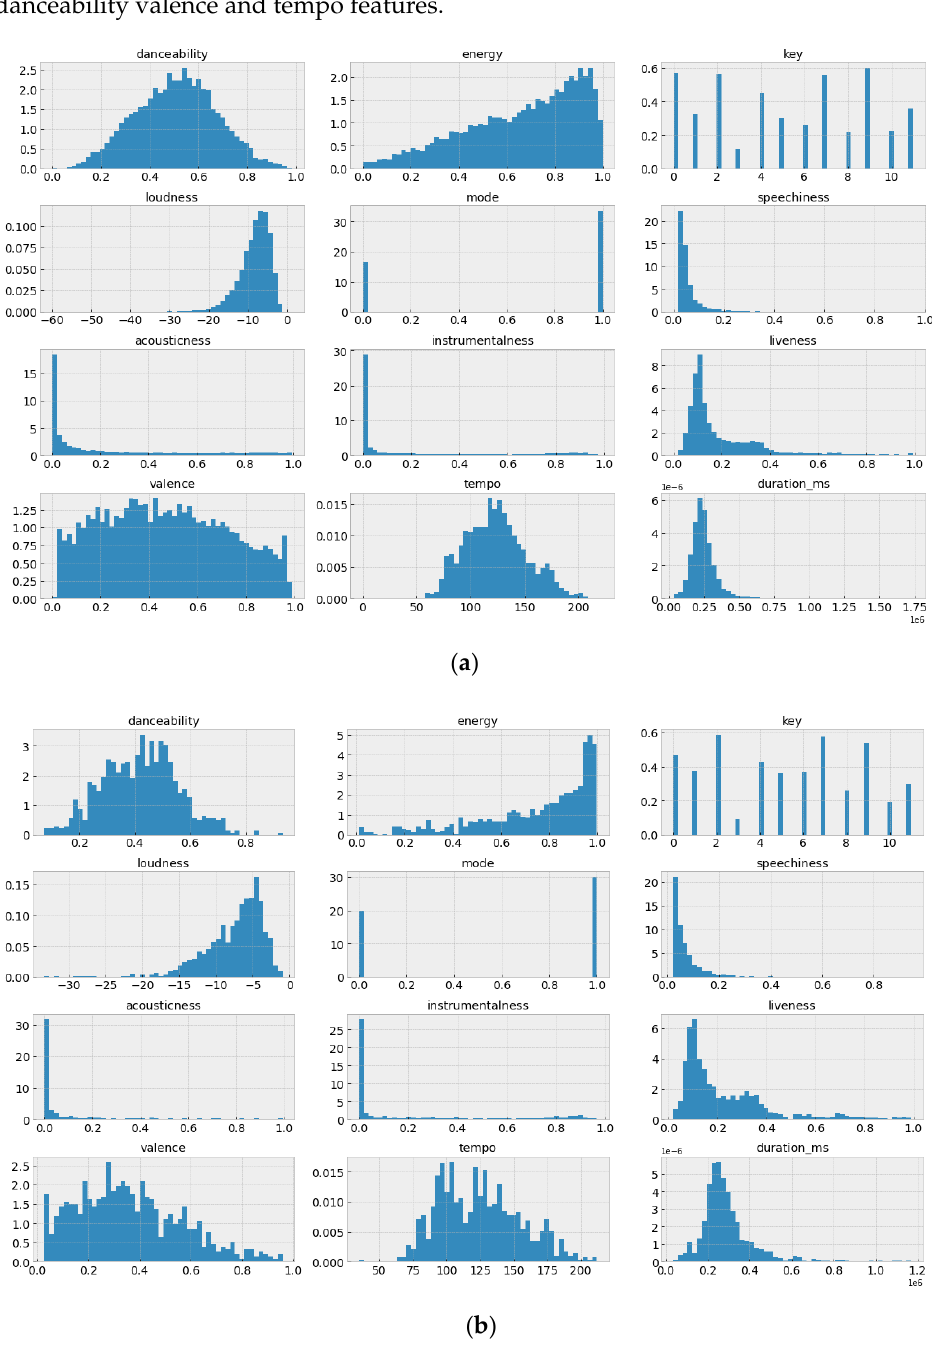
Figure 1. Value distribution of song properties in both datasets ( a ) LastFM-lk-spotify and ( b ) LFM-lb-